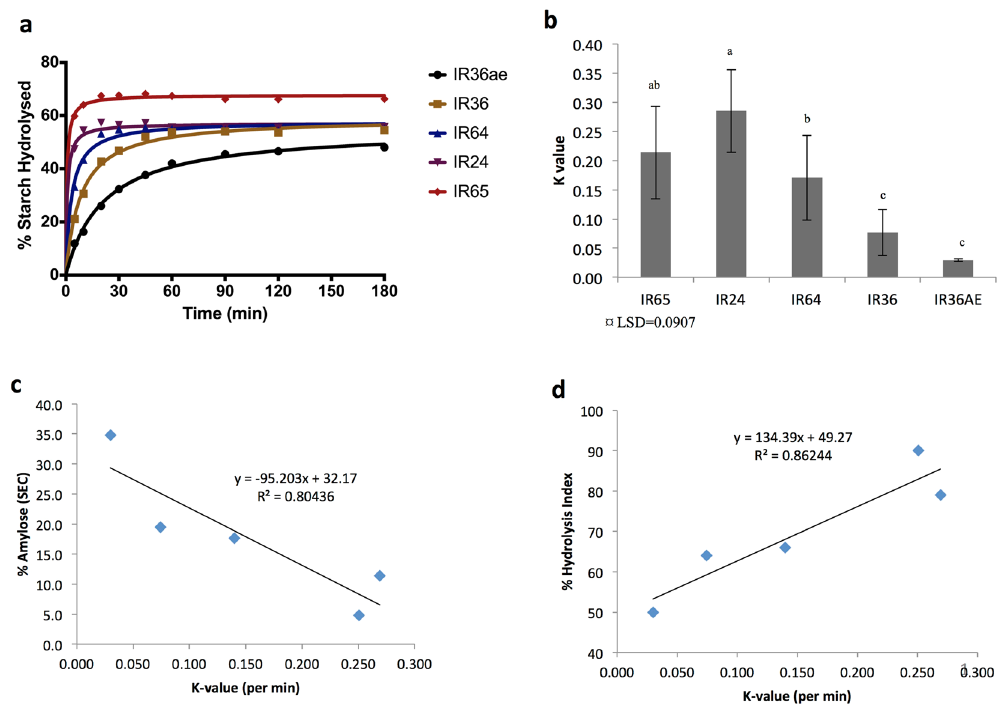
Figure 2. Digestion kinetics of five contrasting lines. ( a ) In vitro starch digestion by cooked grain amylolysis and derived ( b ) digestion rate constants ( k value) using the logarithm of slope (LOS) method. The kinetics of starch digestion is described by comparing the k value with ( c ) percent amylose and ( d ) predicted